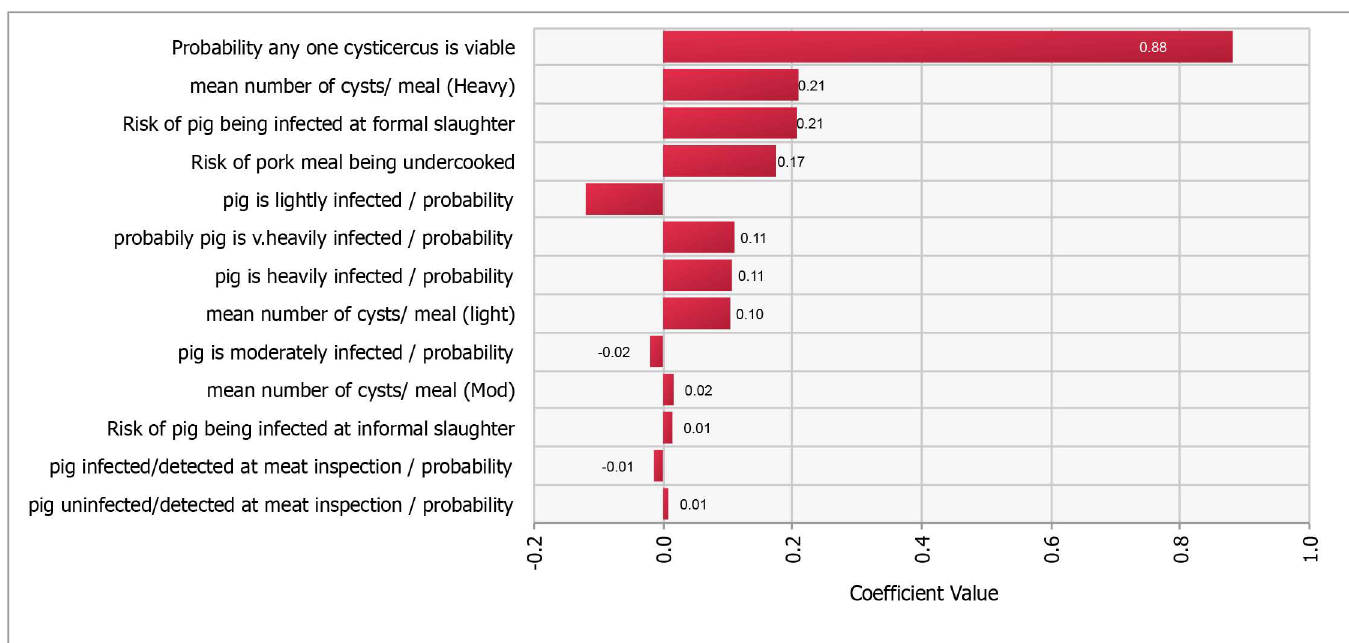
Fig 3. Tornado Graph illustrating the Spearman’srank order correlation co-efficient values for different inputs.